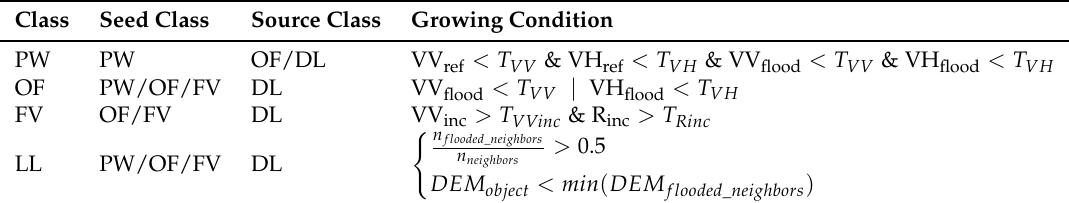
Table 3. RG parameters for the PW, OF, and FV